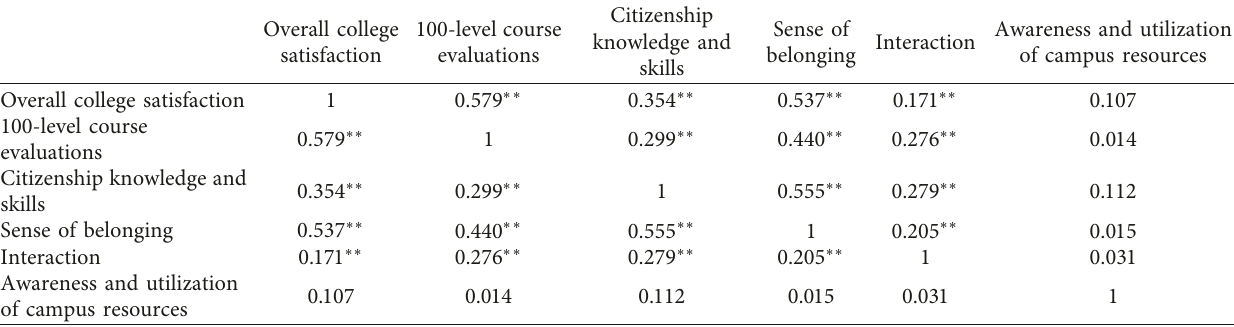
Table 4: Pearson’s correlation between overall student satisfaction and the five factors.